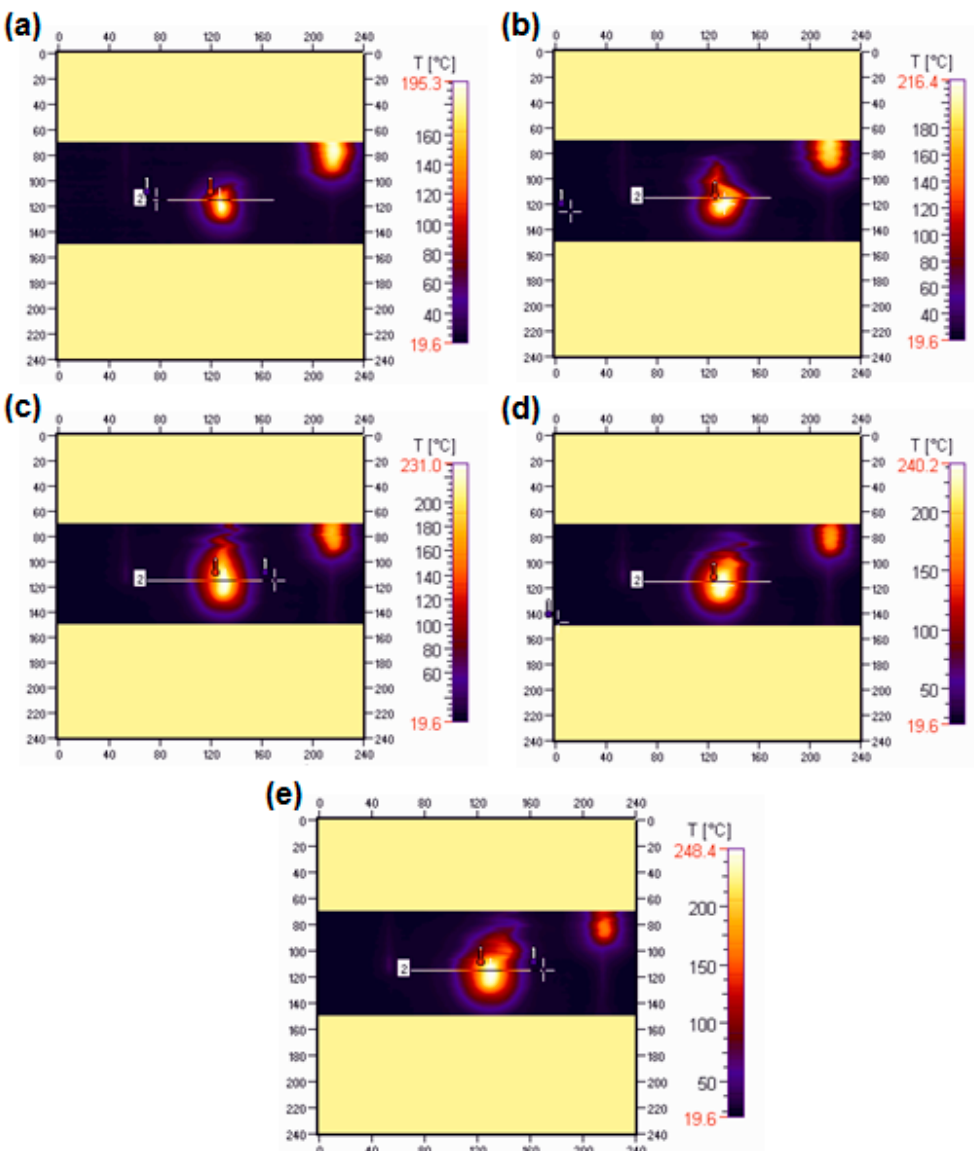
Figure 12. Thermograms of sample 6 (BPA.DM-NVP-5) recorded: 20 ( a ), 25 ( b ), 30 ( c ), 35 ( d ) and 40 ( e ) seconds after the ignition source application. Table 4. Data from the thermographic camera